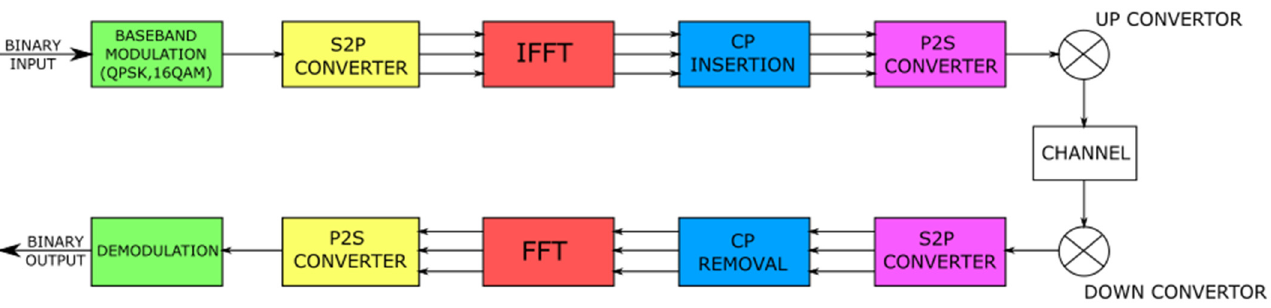
Figure 4. Block diagram of the transmitter and the receiver of the OFDM signal.